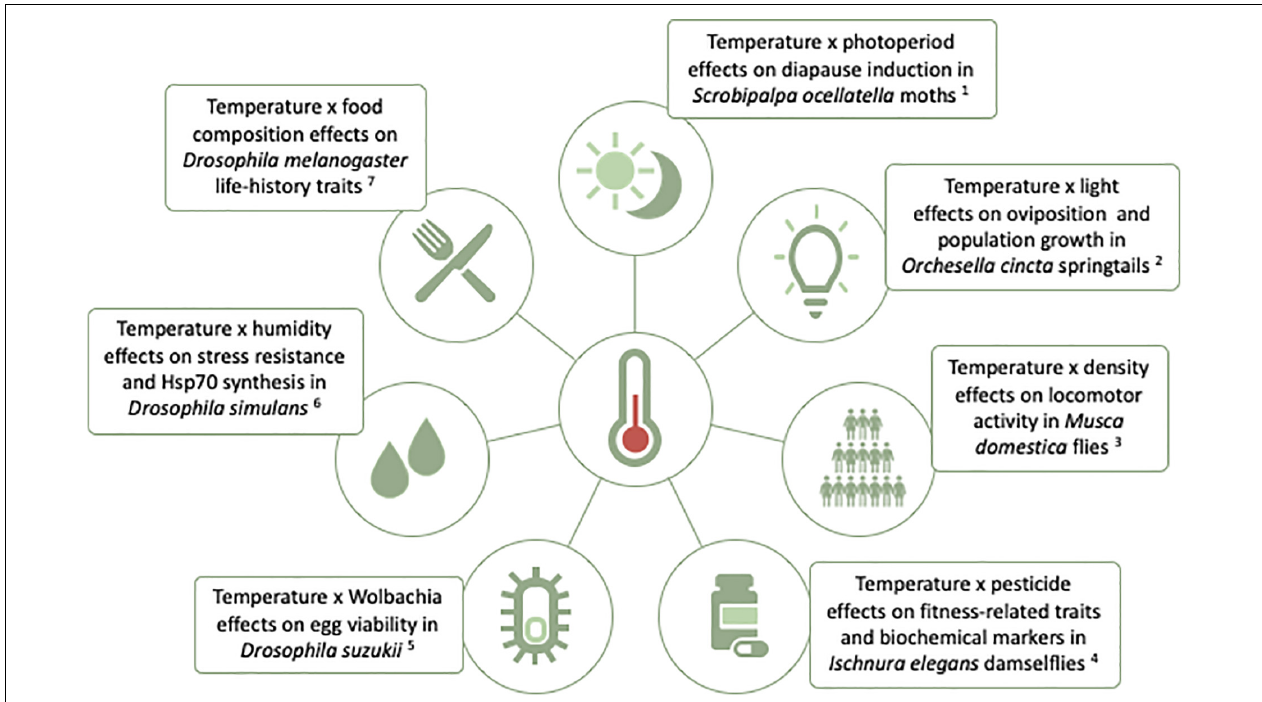
FIGURE 2 | Insect examples of studies of effects of temperature combined with other environmental factors on phenotypic plasticity. Examples from: 1 Ahmadi et al., 2018; 2 Liefting et al., 2017; 3 Schou et al., 2013; 4 Arambourou and Stoks, 2015; 5 Saeed et al., 2018; 6 Bubliy et al., 2013; 7 Kutz et al.,